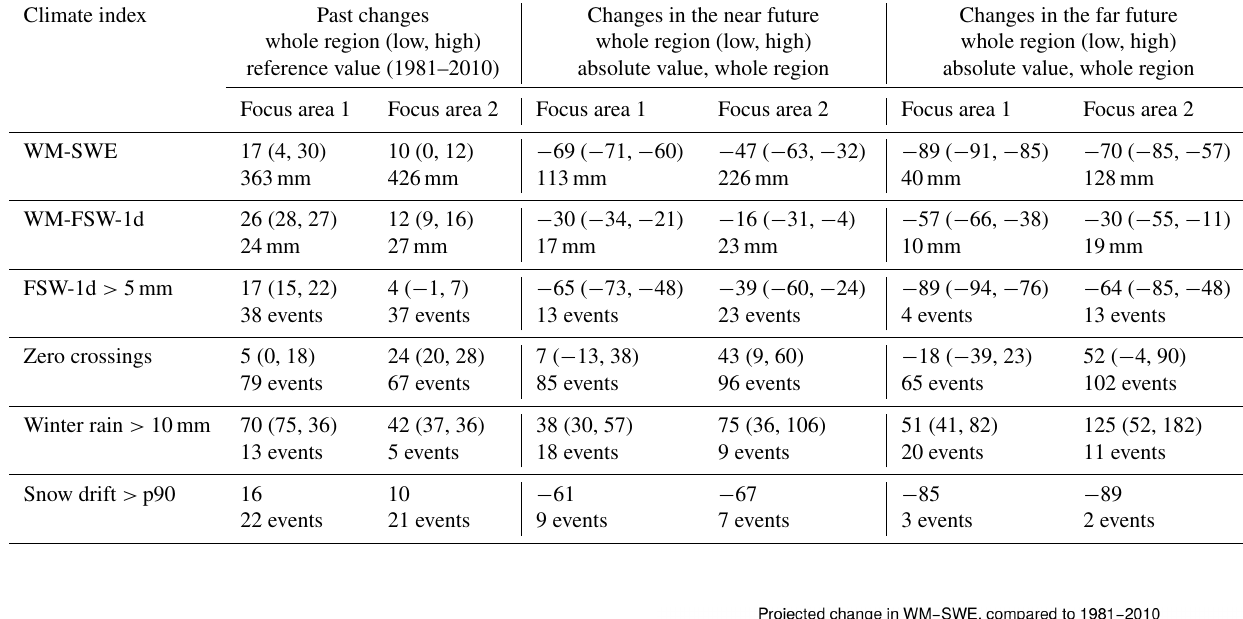
Table 2. Estimated changes in climate indices between two 30-year periods in the two focus areas, based on spatial mean values. In paren- theses we present the change in the lower and higher elevation bands, respectively. Values for snow drift are only based on selected grid cells in high and wind-exposed elevations. All values are in percent (%), except absolute values on the second line in each cell. Past change refers to the change between the first and the last 30-year period during 1958–2017 (for wind: 1958–2015), and a reference value for the period 1981–2010 is given below. Change in the near (far) future refers to change between 1981–2010 and 2041–2070 (2071–2100).